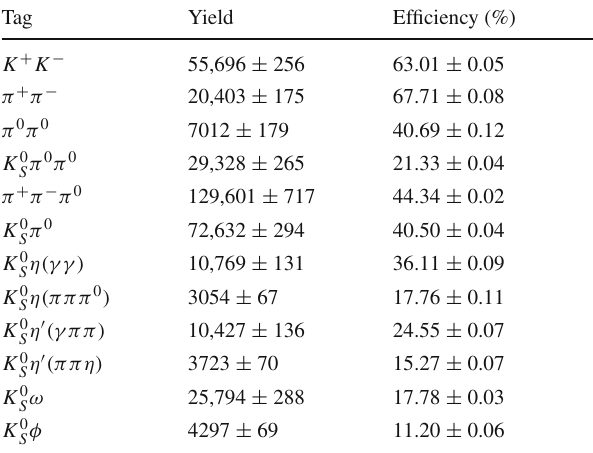
Table 3 Summary of single-tag yields. Also shown are the selection efficiencies as determined from MC simulation, which are defined rel- ative to the exclusive final state in which each channel is reconstructed. The uncertainties are statistical only